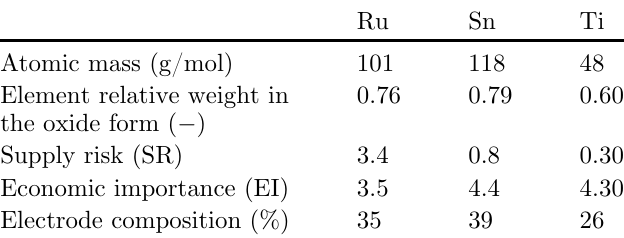
Table A1. Values used for the Critical index computation.